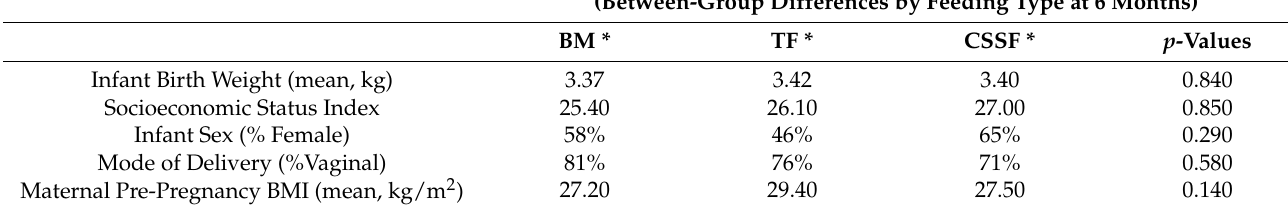
Table 1. Descriptive statistics based on feeding type group at 6 months (n = 115). No significant differ- ences were found in maternal or infant characteristics between groups based on One-Way ANOVA. Participant